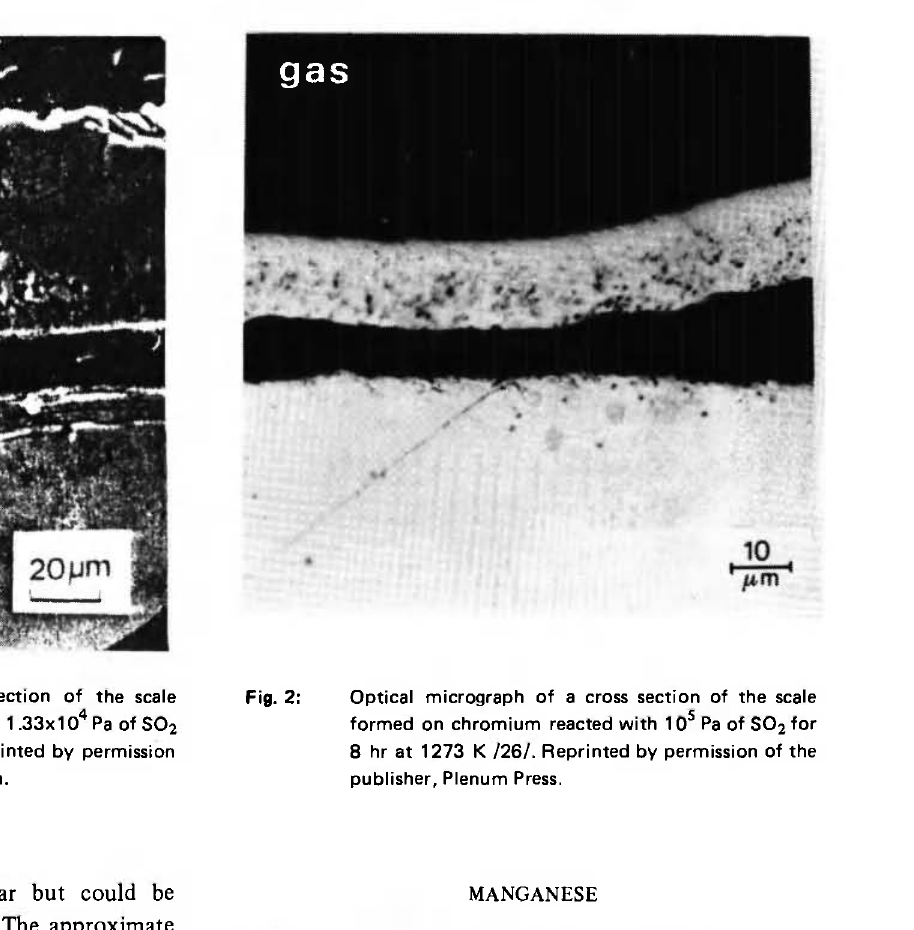
Fig. 2: Optical micrograph of a cross section of the scale formed on chromium reacted with 10 s Pa of S0 2 for 8 hr at 1273 Κ 1261. Reprinted by permission of the publisher, Plenum